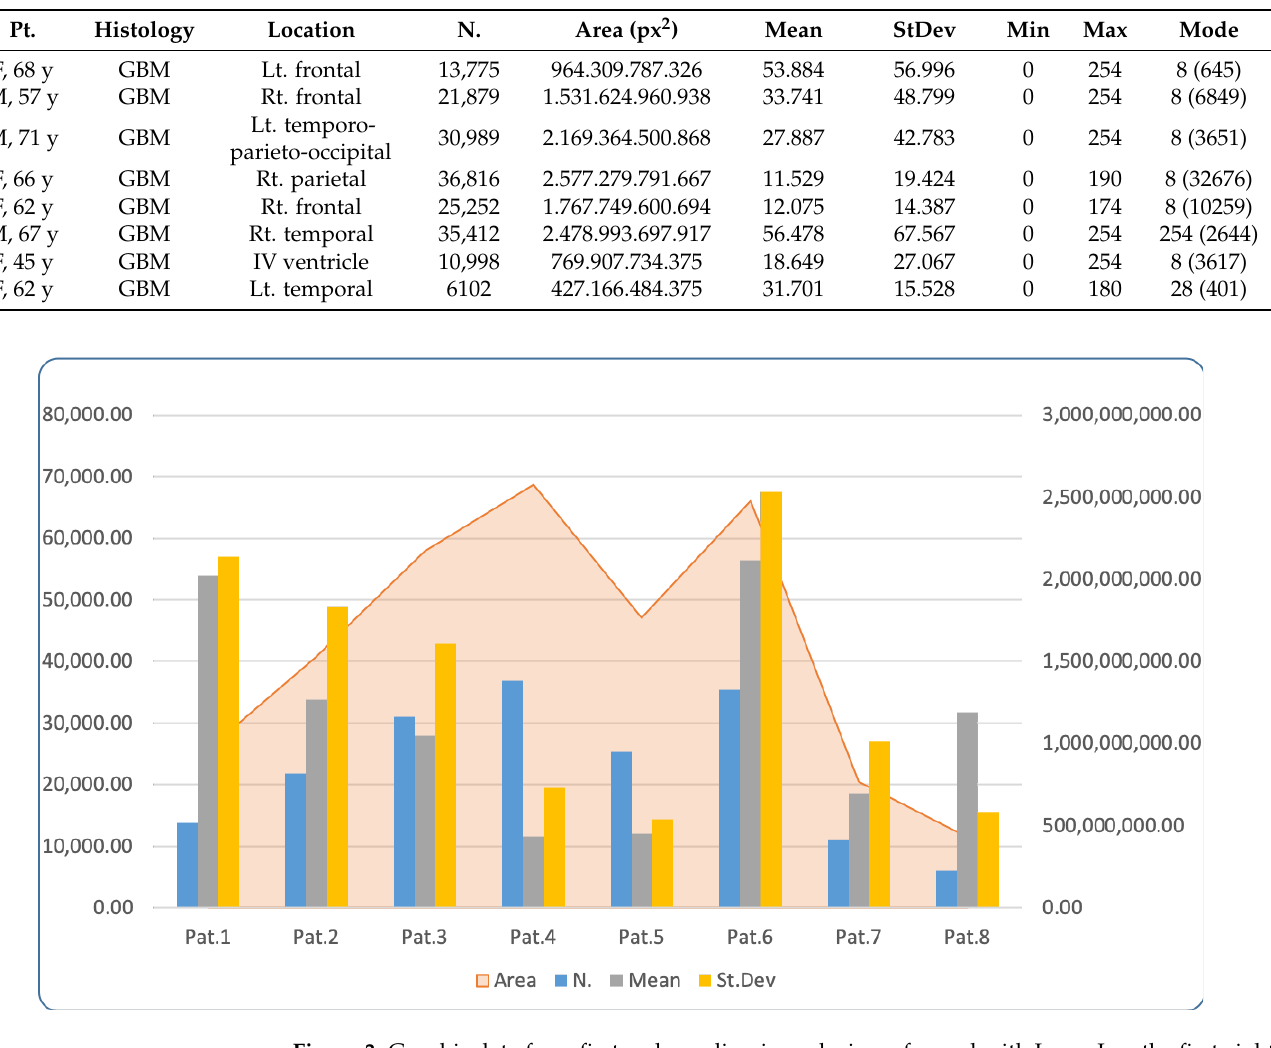
Figure 4. Results of MicroV IOUS images with MV0 color map post-processing for internal valida- tion of the protocol.